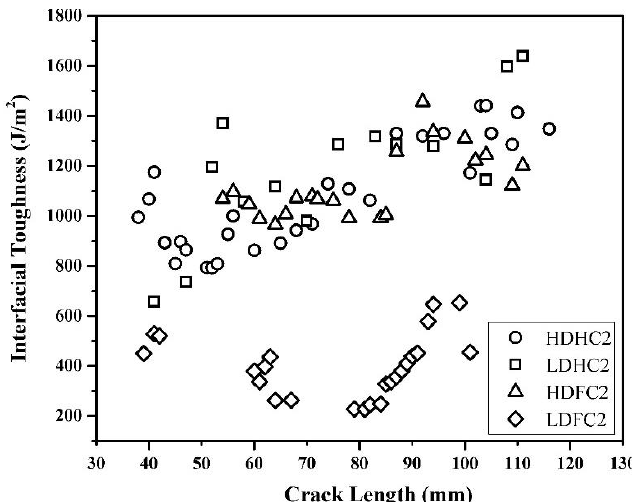
Figure 14. Comparison of debond resistance curve (G IC vs. a) for all 4 SCB sandwich structures.